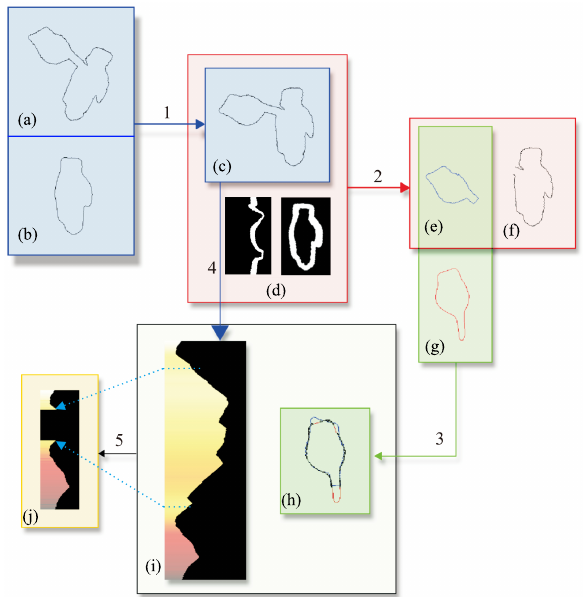
Figure 8: Obtaining an incomplete 1D signature of a pointing hand form from a given simple occluded hand shapes. In step 1, a contour (a) of the given interaction shape is extracted and then aligned to a mean template of palm hand form (b). The result of alignment is presented in (c). In step 2, a mask image of the palm hand form (right side of d) is generated by palm template samples, which are transformed into a polar coordinate system (left side of d). In step 3, the contour of the pointing hand form (e) is aligned to the mean template of the pointing hand form